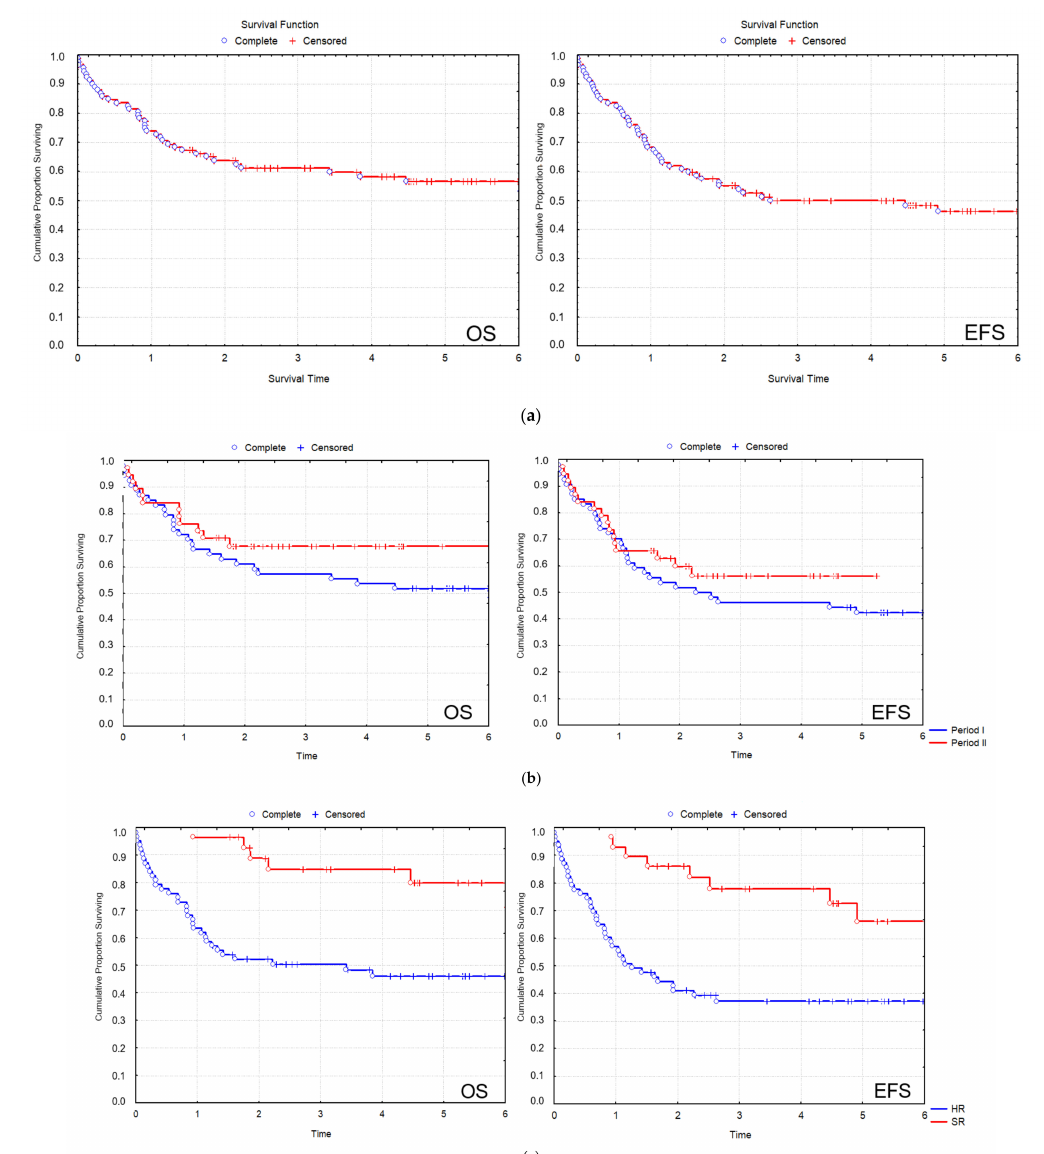
Figure 2. ( a ) Kaplan–Meier analysis of the OS and EFS values in the total cohort of patients between 2012 and 2019. ( b ) OS and EFS curves of SR and HR group of patients. ( c ) OS and EFS of patients registered in Period I (2012–2015) and Period II (2016–2019). (5 y OS of Period I and Period II was 52% and 67%, respectively, p < 0.05, Cox F test; 5 y EFS of Period I and Period II was 44% and 55%, respectively, p = 0.105, Cox F test). Abbreviations: EFS: event-free survival, HR: high risk, OS: overall survival, SR: standard